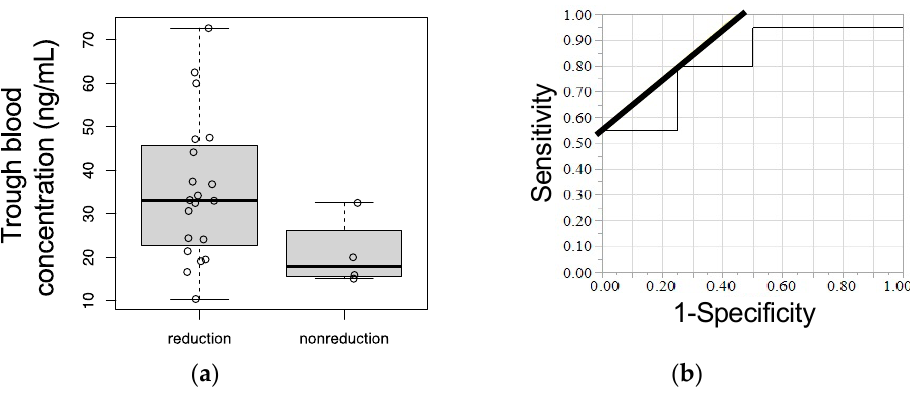
Figure 3. Relationship between the trough plasma concentration of afatinib and continuous dose/dose reduction. ( a ) Boxplot of distribution for the trough plasma concentration of afatinib between continuous dosage and dose reduction. ( b ) Receiver operating characteristic curve for the trough plasma concentration of afatinib. Table 2. Logistic regression analysis for the dose reduction of afatinib and the parameters of the receiver operating characteristic (ROC) curve.